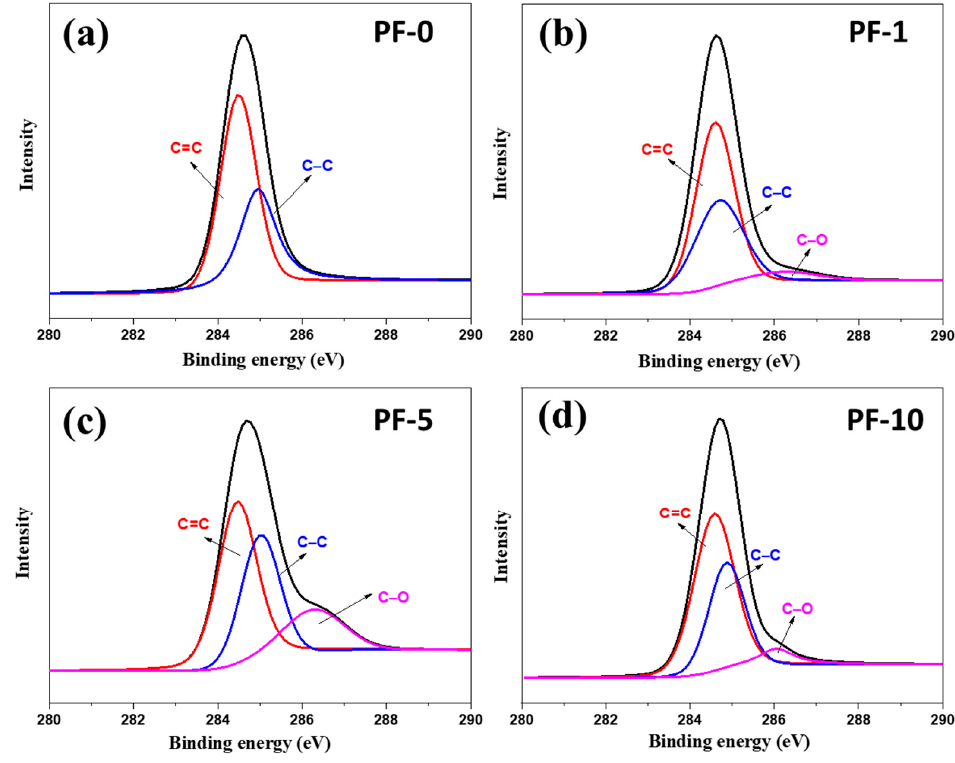
Table 1. XPS Results of Different PIM-Derived Pitch Fibers.